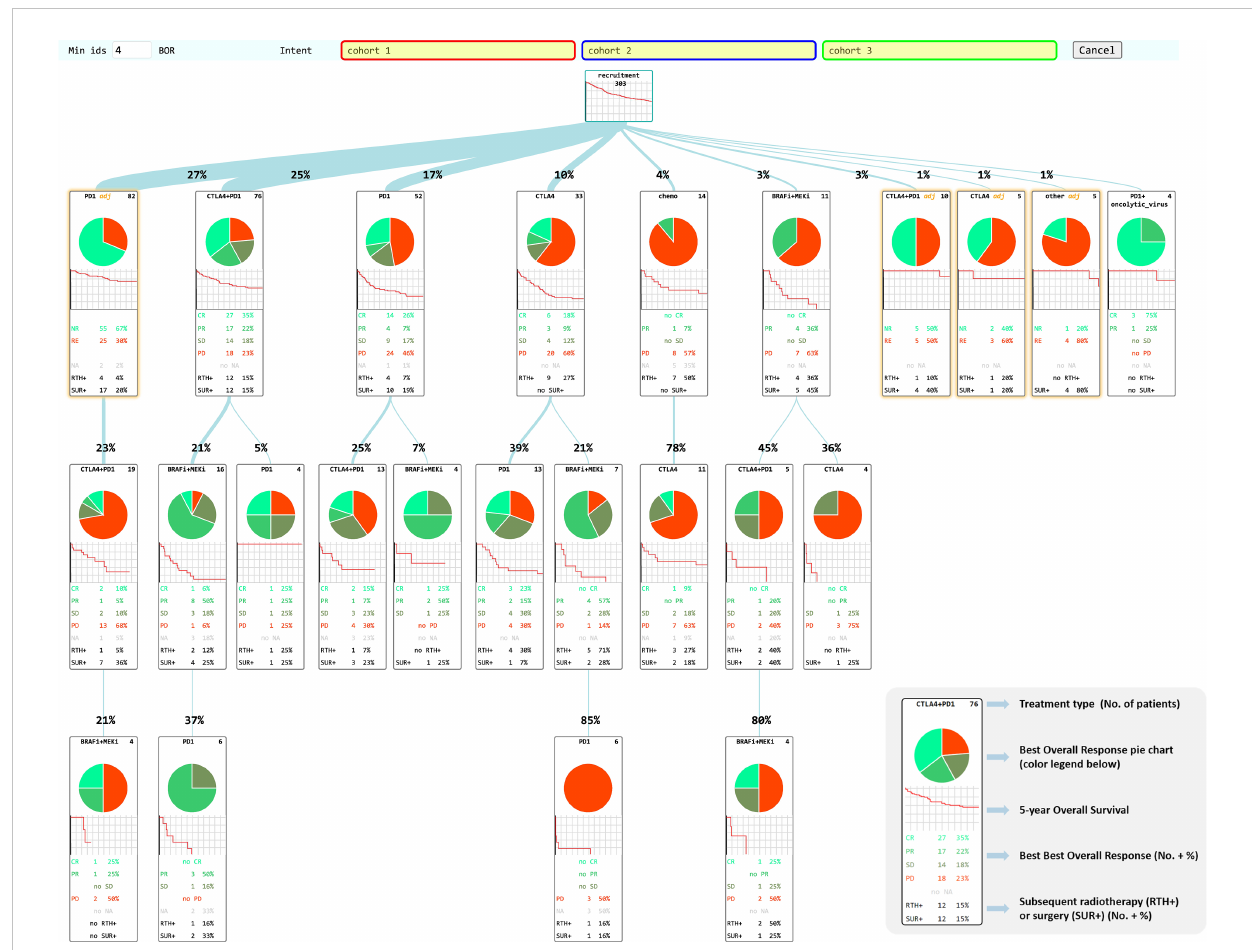
FIGURE 2 CHUV-RWD Melanoma Treatment Tree. Each box represents a new treatment line and the thickness of the branch depends on the percentage of patients from the parent box undergoing the next drug treatment. The legend in the bottom right corner details the information contained in each box of the tree. Adjuvant treatments are outlined in yellow. The red, blue, and green boxes at the top allow drag-and-drop custom cohort selection to generate OS and PFS curves as shown in the following sections. Each Sub-groups of patients detailed in each box can be accessed through a right-click and examined in the SQL-Tools or added to/subtracted from a custom